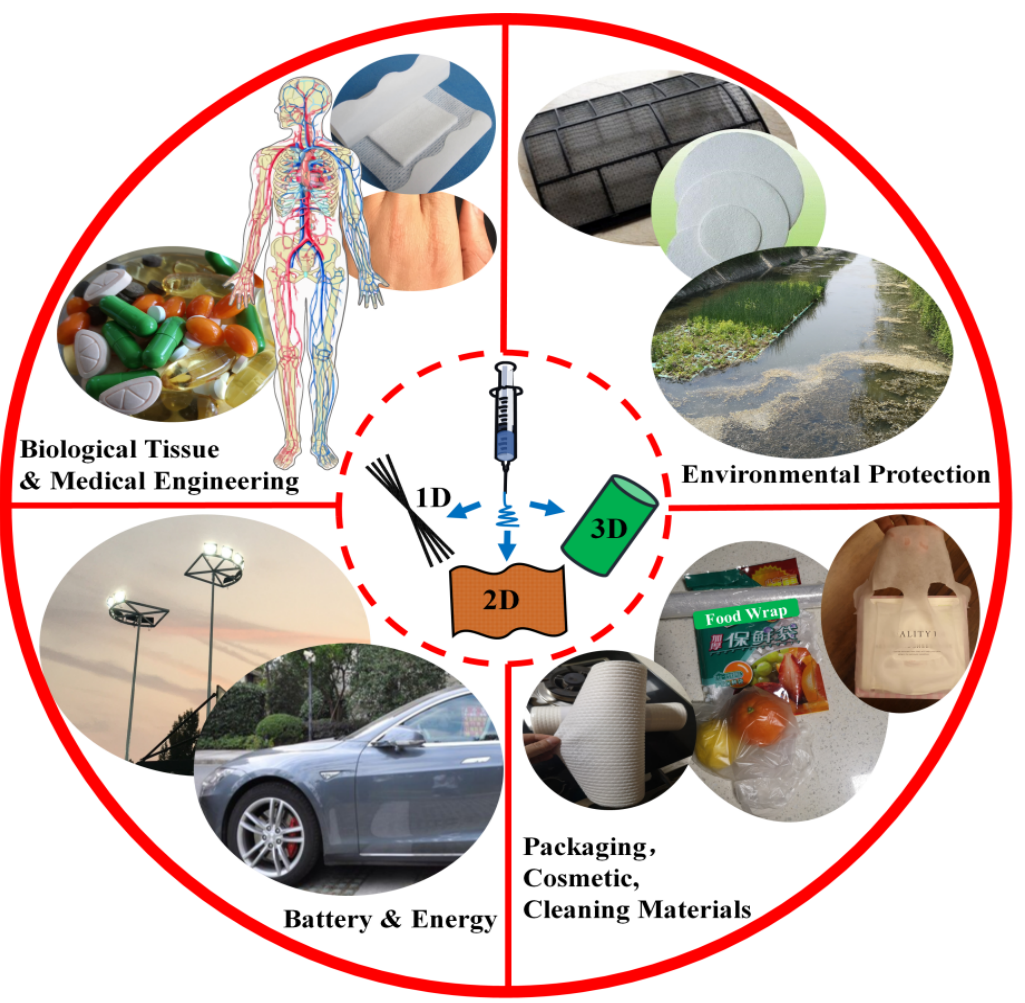
Figure 1. The electrospun nanofibers that can be assembled to 1D, 2D, and 3D structures, and their related sustainable applications. These nanofibrous materials are of special properties, such as superhydrophobicity, superhydrophilicity, superconductivity, and adjustable mechanical properties, which have led to widespread ecofriendly applications in batteries, environmental consciousness, biological tissue, and medical engineering, as well as food packaging and cosmetic